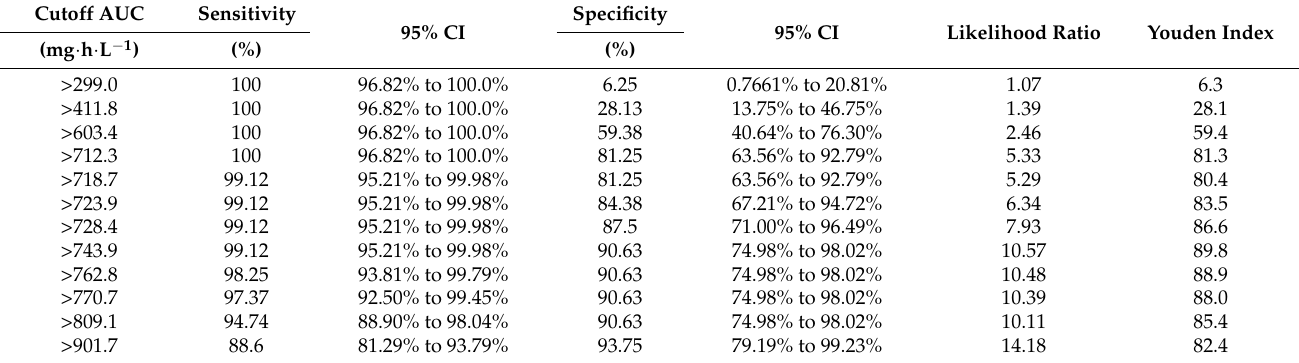
Table 2. Selection of target AUC.